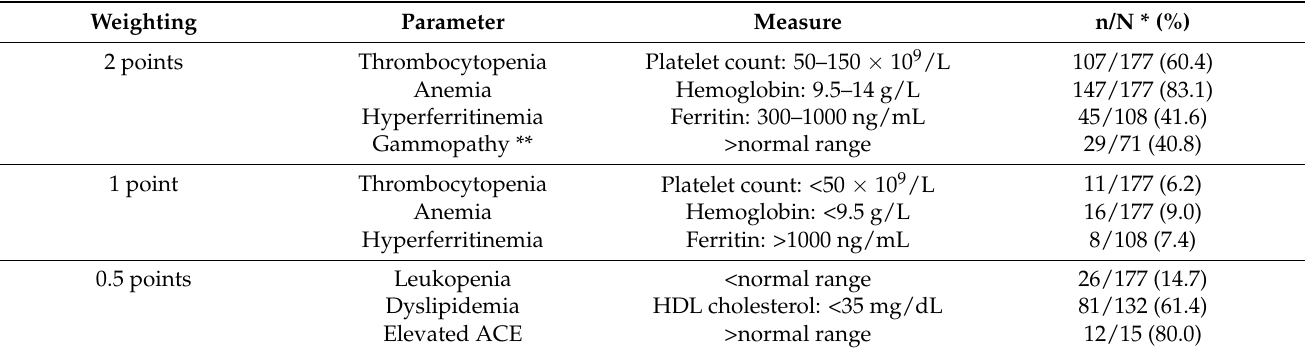
Table 4. Application of the GED-C scoring system to patients with confirmed Gaucher disease: laboratory-based items.